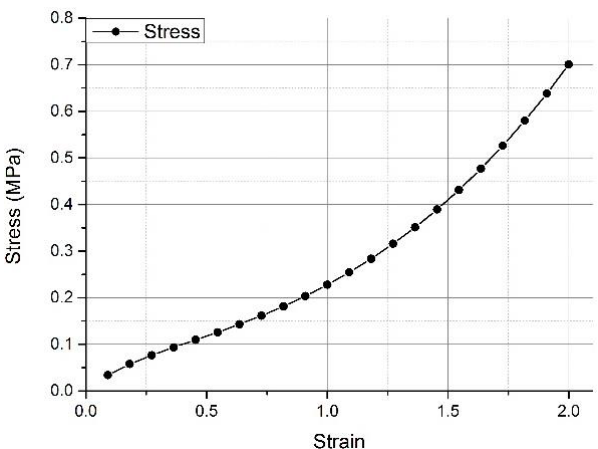
Figure 3. Finite element analysis (FEA) model of ( a ) the whole model (WM) and ( b ) the skeletal structure foot model (SSM).